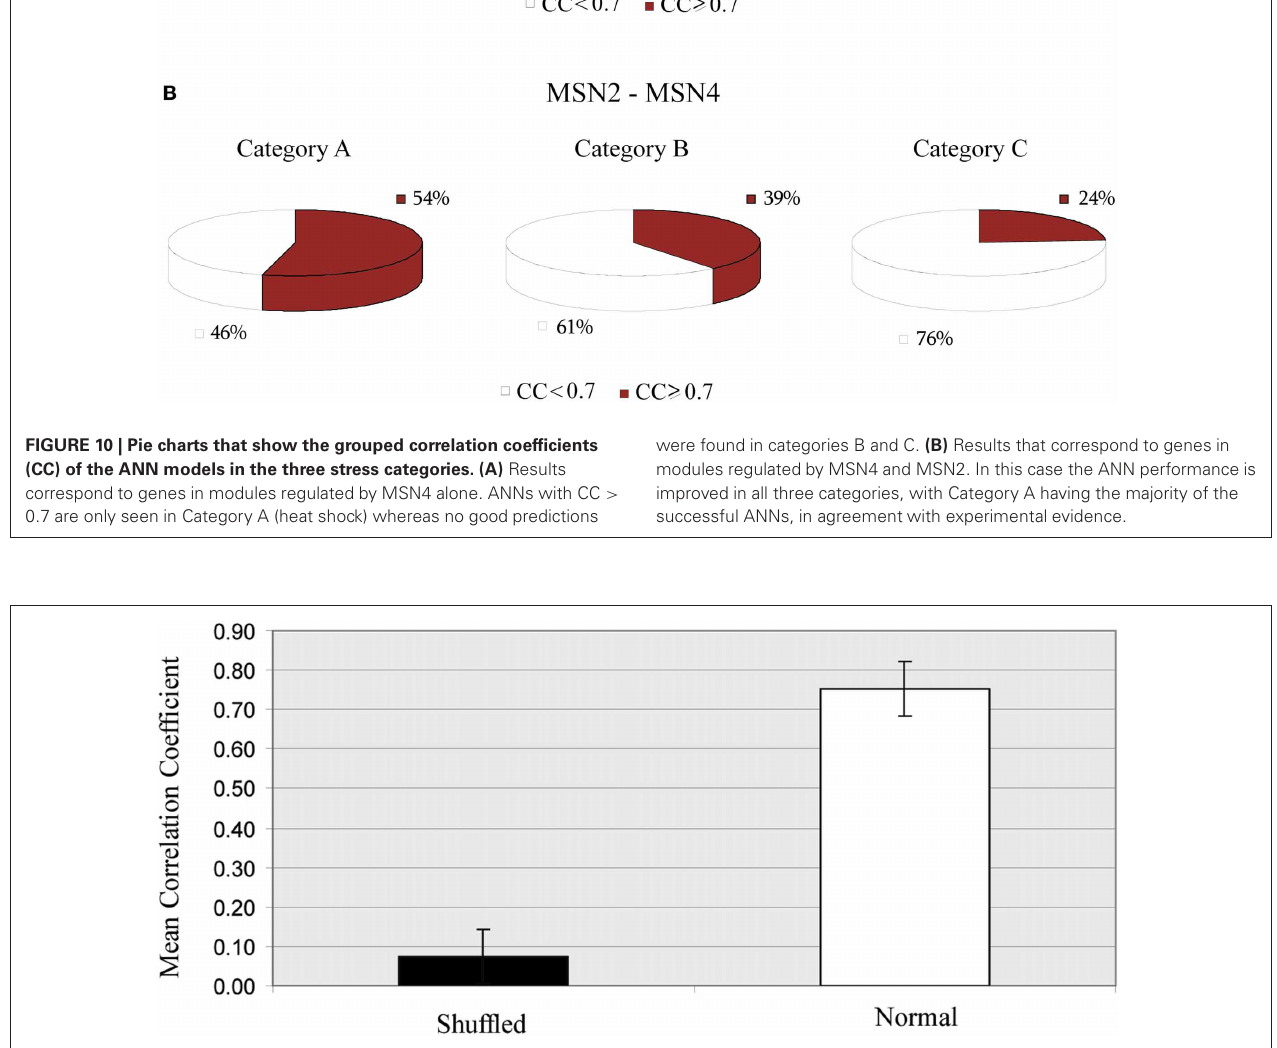
FIGURE 11 | Correlation coefficients of the normal and shuffled data. Bars show the mean and standard deviation of the correlation coefficients achieved by all ANN models when either the normal (white) or randomly shuffled (black) expression profiles for the target gene where used to train the